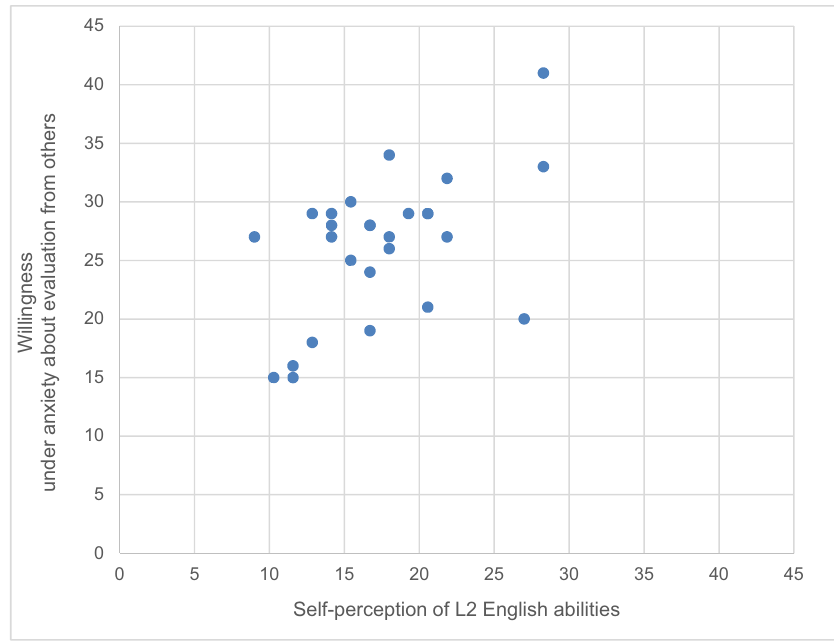
Figure 5: Correlation between willingness under anxiety about evaluation from others and self - perception of L2 abilities ( Likert points )